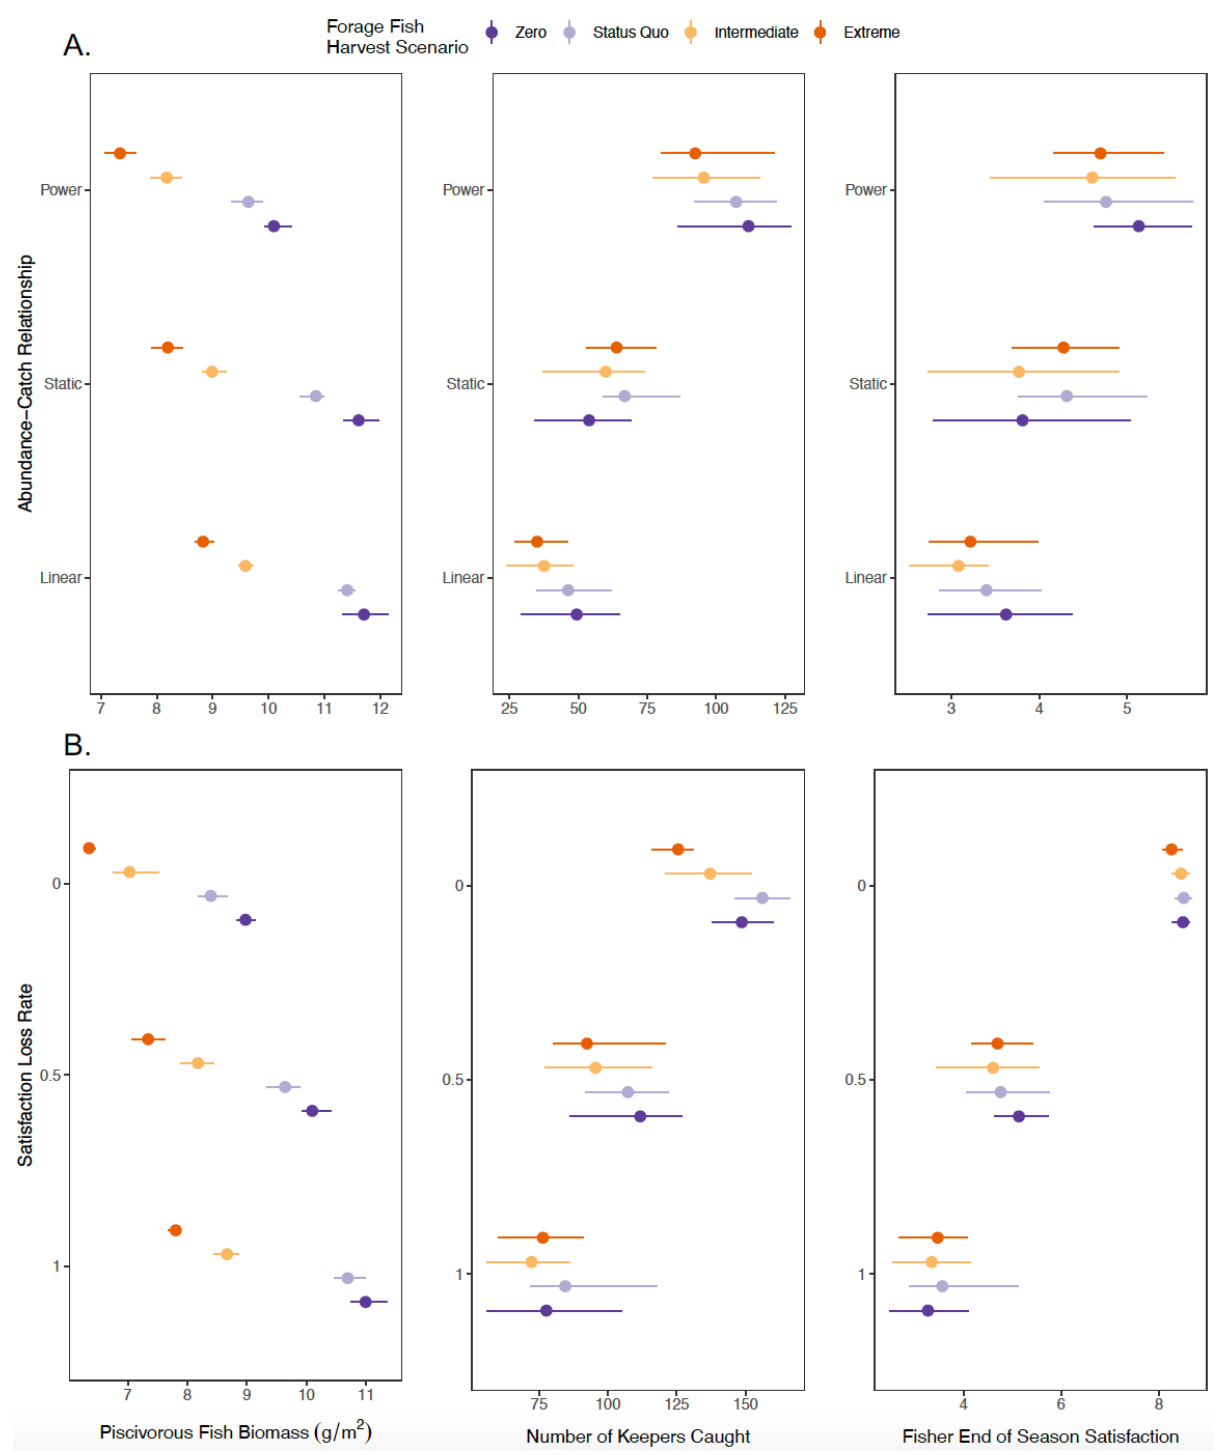
Fig. 6 . The mean and data spread (of each 8-year trial) of piscivorous fish biomass, the number of keepers caught, and recreational fisher end of season satisfaction across harvest scenarios, where the top row (A) shows the abundance-catch relationship trials, and the bottom row (B) shows the satisfaction loss rate trials. Color indicates the scenario of commercial forage fish